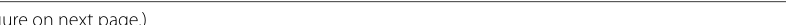
figure on next Fig. 1 AC-YVAD-CMK improved spatial learning and memory ability and reduced senile plaque deposition of APP/PS1 mice. APP/PS1 mice were intraperitoneally injected with AC-YVAD-CMK or DMSO. WT C57/BL6 mice were served as control. a , b Spatial learning and memory ability of mice were detected by morris water maze. c , d Immunohistochemistry and Thioflavin S staining were performed to examine the senile plaque deposition in the hippocampal tissues (subregions between DG and CA1) of mice. e TUNEL staining was performed to assess apoptosis in hippocampal neurones of mice. The arrows indicated the Aβ 1-42 . (One-way ANOVA; ** P < 0.01 vs. WT group; ## P < 0.01 vs. APP/PS1